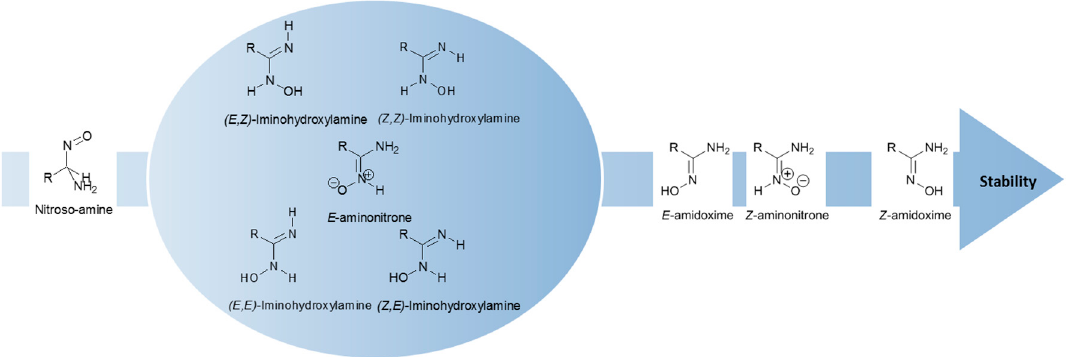
Figure 4. Summary of the stability of amidoxime isomers.